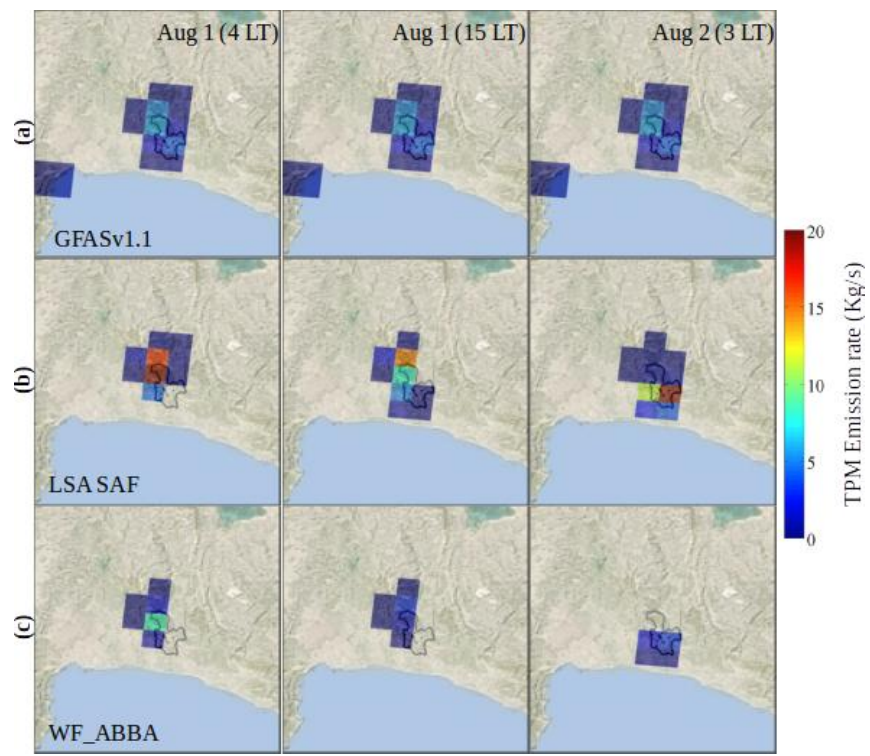
Figure 5. Horizontal allocation of the Antalya fire emitting pixels during 1 August 2008 as derived by GFASv1.1 (a) , LSA SAF (b) and WF_ABBA (c) FRP-based fire emission inventories. Black line is the ground reported burned area (on the upper-right corner of this picture, 03:00LT of 2 August means 24:00UTC of 1